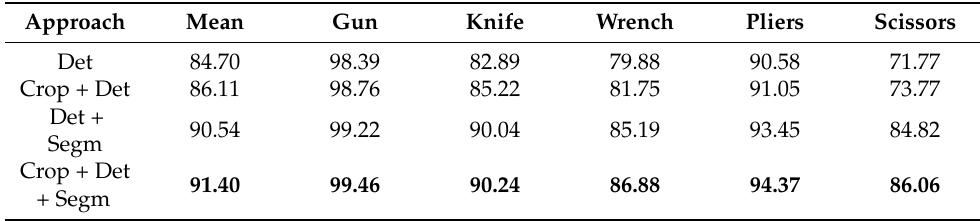
Table 8. Classification mean average precision (%) of the ablation study using